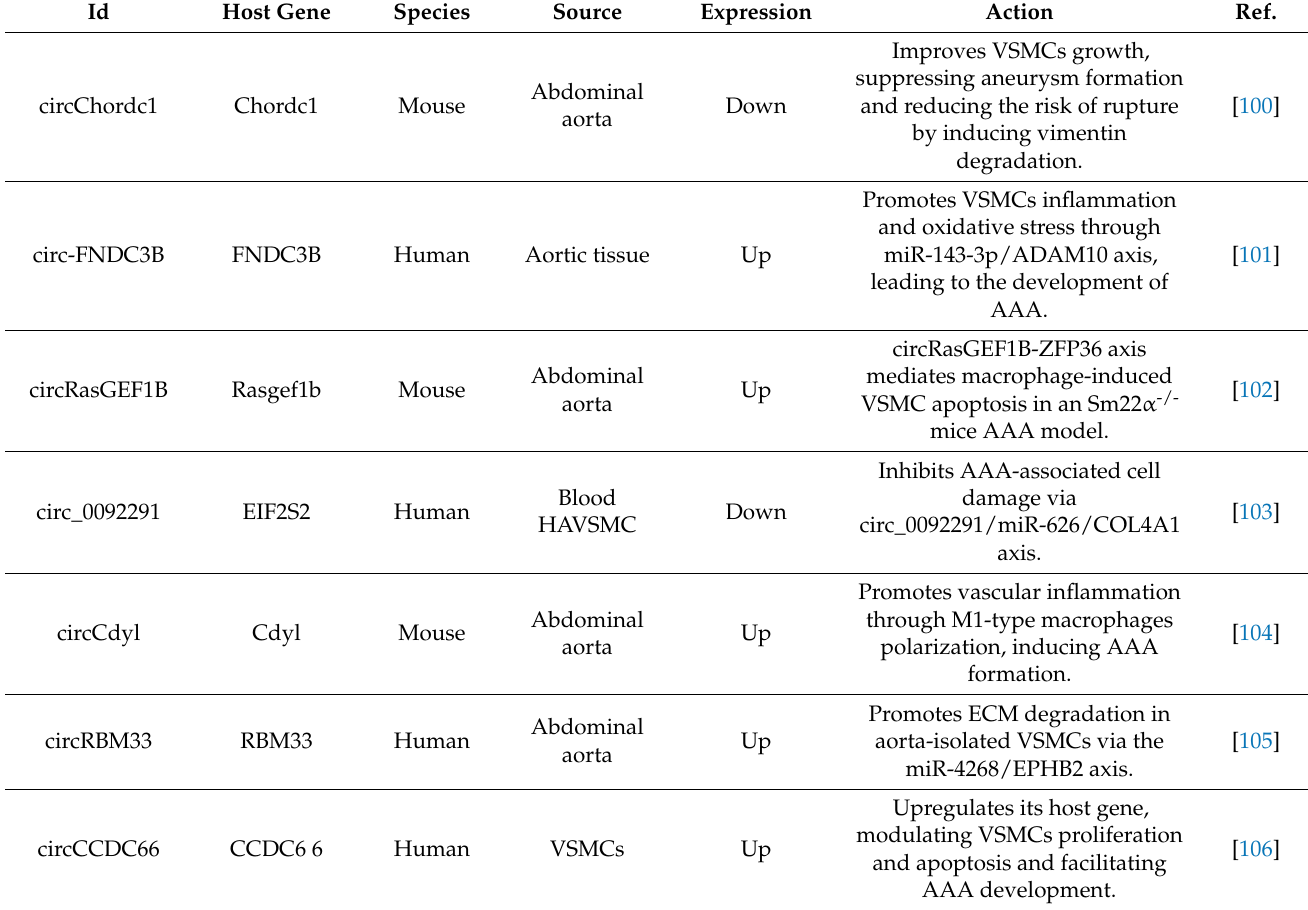
Table 4. List of circRNAs associated with